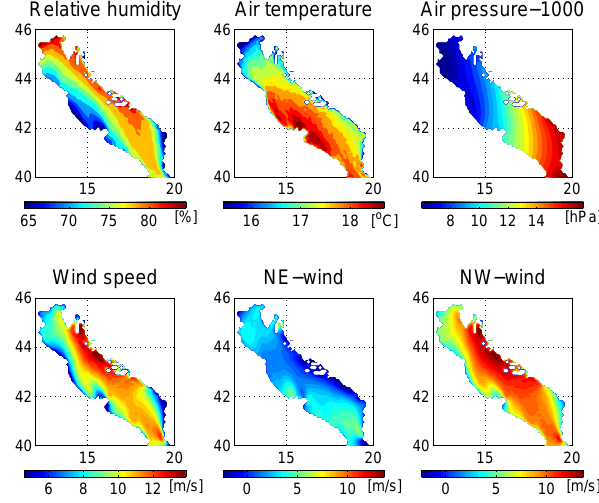
Fig. 2. ALADIN mean fields over the 63 sirocco episodes.